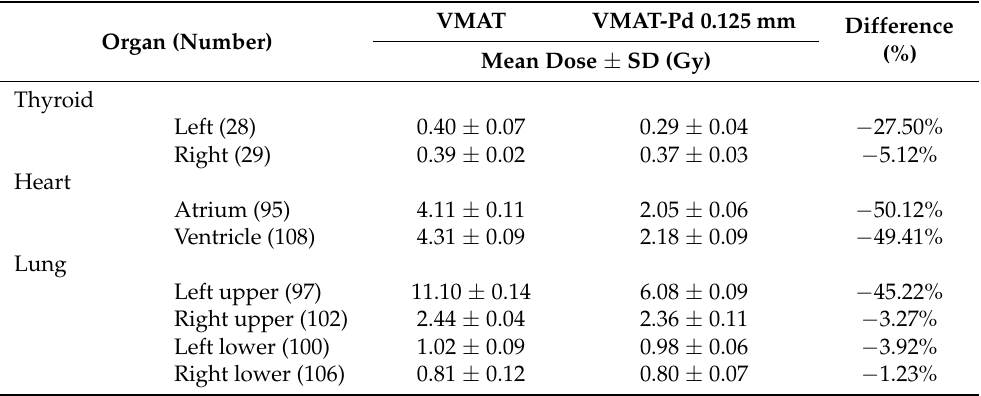
Table 6. Comparison of the OAR doses of the VMAT plan before and after 0.125mm of lead shields were applied to the surface of the